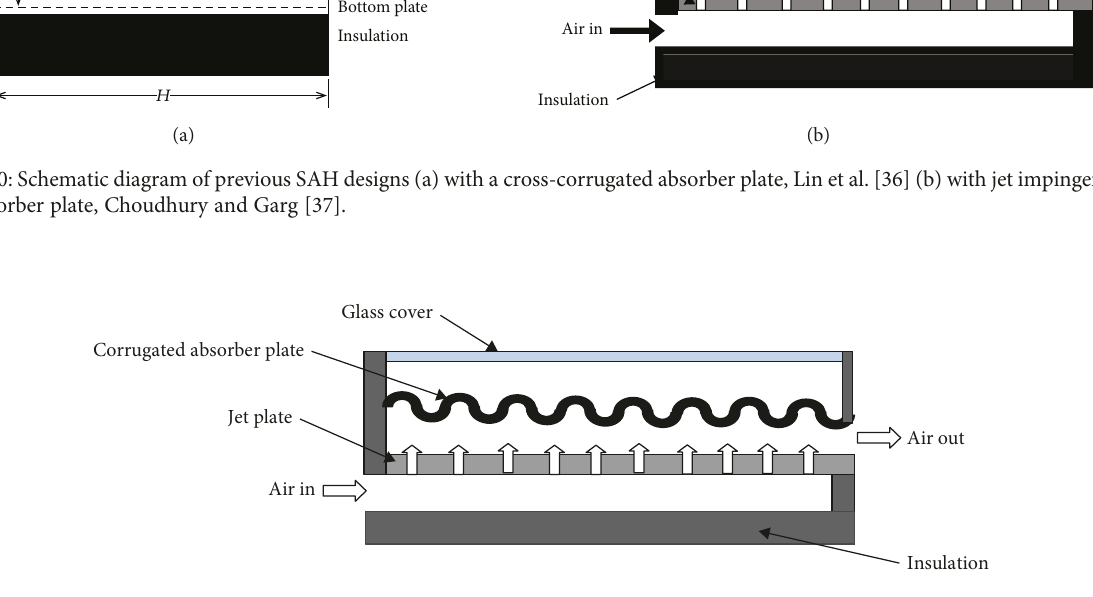
Figure 11: Schematic diagram of the proposed design of SAH with jet impingement on a corrugated absorber